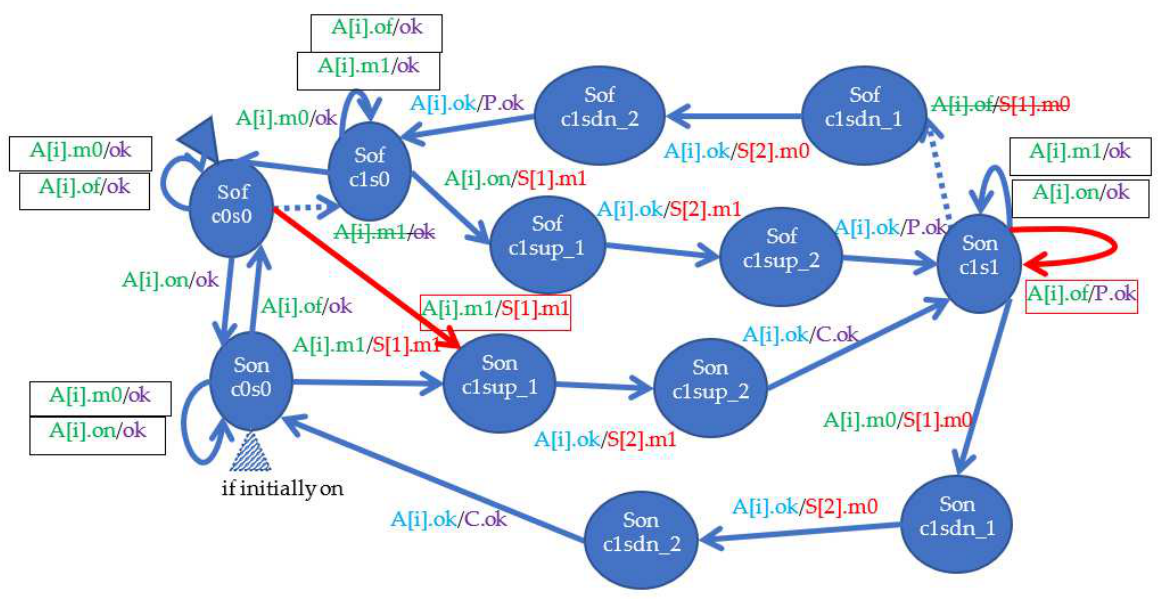
Figure 14. Damaged element—a permanent short-circuit between input and contact output.